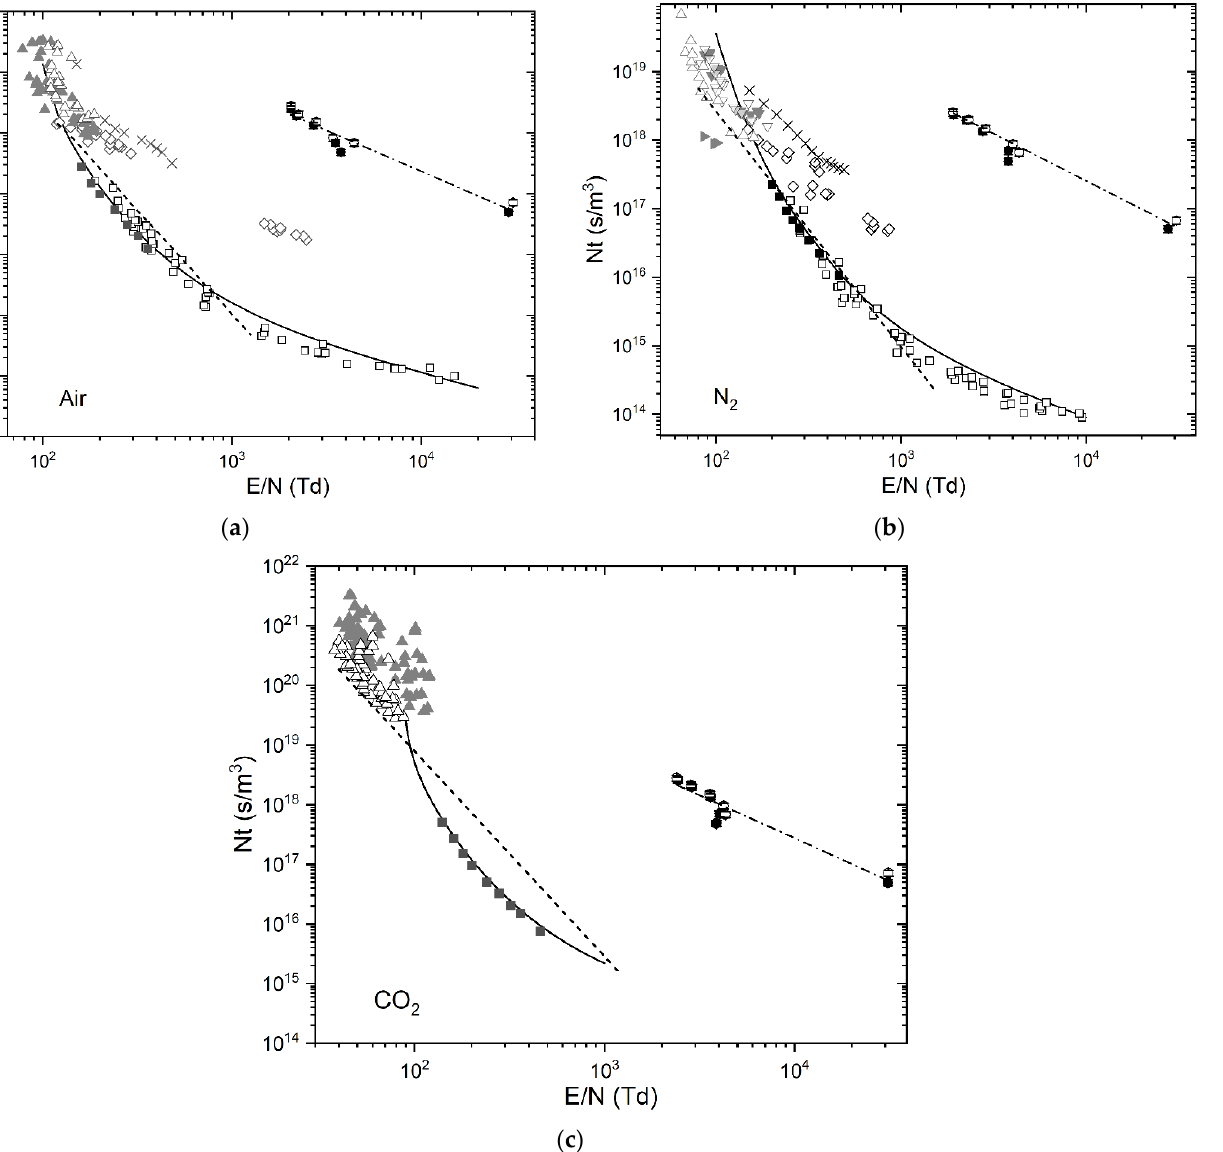
Figure 11. ( a ) Field-time breakdown characteristics for in air. Experimental data, present work, Nt br ( E tip / N ): ○ —negative polarity; ● —positive polarity. Fitting curves obtained: dash dotted line, Equa- tion (7). Experimental data from the literature: △ —negative polarity (monocone) [24]; ▲ —positive polarity (monocone) [24]; × —[23]; ◇ —[22]; —[36]; dashed line [37]; analytical data, Nt f ( E / N ) , from the literature: ■ —drift-diffusion model [34]; solid dark line, kinetic model equation (5). ( b ) Field-time breakdown characteristics for in N 2 . Experimental data, present work, Nt br ( E tip / N ): ○ — negative polarity; ● —positive polarity. Fitting curves: dash dotted line, Equation (7). Experimental data from literature: △ —negative polarity (point-plane) [24]; ▽ —negative polarity (monocone) [24]; ▲ —positive polarity (point-plane) [24]; ▼ —positive polarity (monocone) [24]; × —[23]; ◇ —[22]; —[36]; dashed line [37]; analytical data, Nt f ( E / N ) , from literature: ■ —drift-diffusion model [34]; solid dark line, kinetic model Equation (5), Nt f as a function of E / N . ( c ) Field-time breakdown char- acteristics for CO 2 . Experimental data, present work, Nt br ( E tip / N ): ○ —negative polarity; ● —positive polarity. Fitting curves, dash dotted line, Equation (7). Experimental data from literature: △ —neg- ative polarity (rod-plane) [11]; ▲ —positive polarity (rod-plane) [11]; dashed line [37]; analytical data, Nt f ( E / N ) , from the literature: ■ —drift-diffusion model [34]; solid dark line, kinetic model Equation (7).